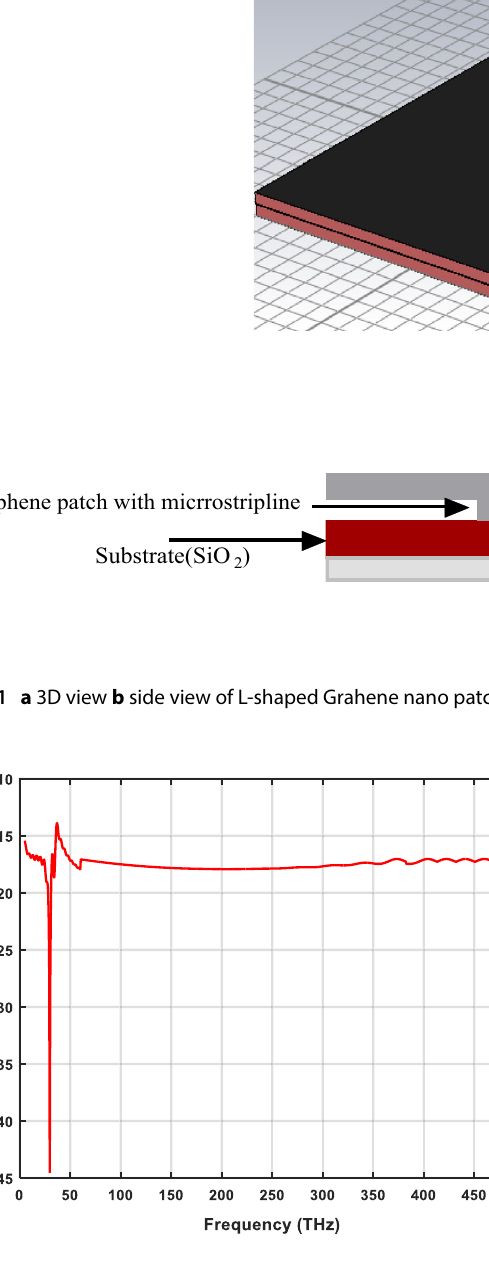
Fig. 12 S parameters of L-shaped graphene nano 11